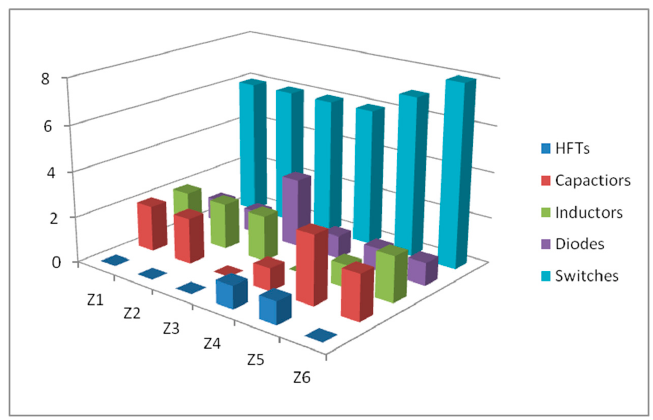
Figure 17. Analysis of components’ count utilized in three-phase Z-source microinverter topologies presented elsewhere (see